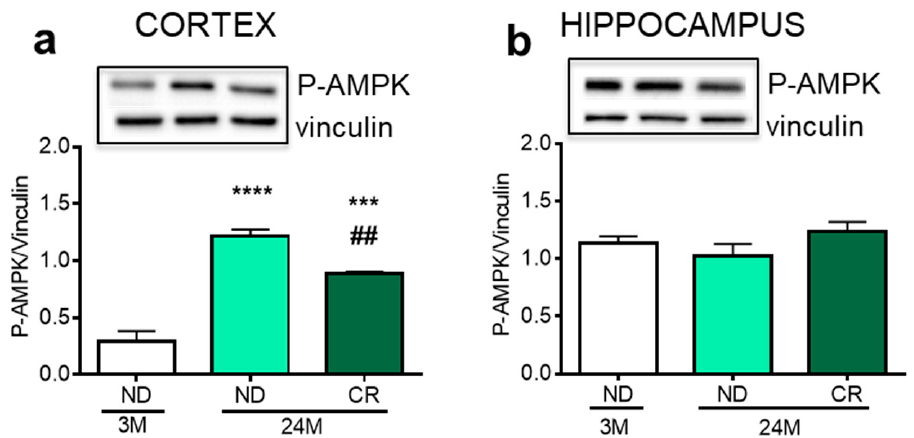
Figure 1. Impact of aging and reduction of caloric intake (CR) on phosphorylated AMPK levels in the rat cortex and hippocampus. Representative Western blots and densitometric analyses of phosphorylated AMPK (P-AMPK) in cortex ( a ) and hippocampus ( b ), using vinculin as housekeeping protein for loading control. 3M (3-month-old rats); 24M (24-month-old rats); ND (normal diet); CR (caloric intake reduced by 40% for the last six months of life). Statistical analysis was performed by using one-way ANOVA followed by Tukey’s post hoc test. **** p < 0.0001, *** p < 0.001 vs. ND 3M; ## p < 0.01 vs. ND 24M.